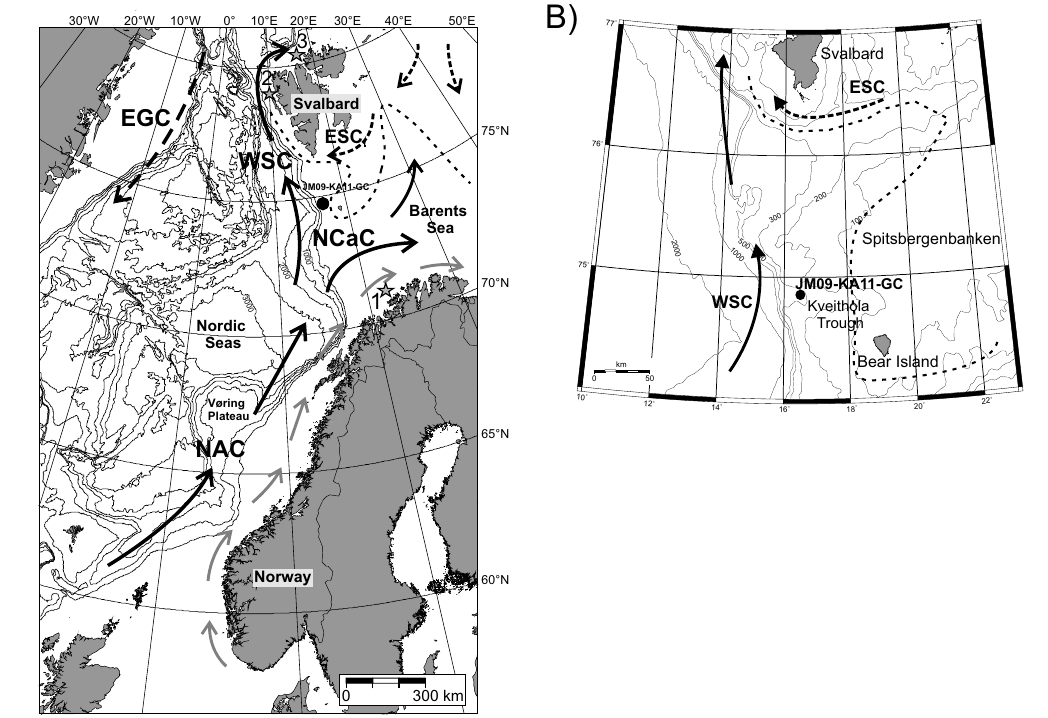
Fig. 1. (A) Location of core JM09-KA11-GC together with main surface current systems in the region. Dashed line indicates the present-day position of the Arctic front (after Loeng, 1991). Black currents indicate Atlantic water, grey currents coastal water, dashed black currents Arctic water. Abbreviations are NAC, North Atlantic Current; NCaC, North Cape Current; WSC, West Spitsbergen Current; ESC, East Spitsbergen Current; EGC, East Greenland Current. Numbers indicate cores used for comparison, 1: core PSh-5159N (Risebrobakken et al., 2010), 2: core NP05-11-21GC (Skirbekk et al., 2010), 3: core NP94-51 (´Slubowska et al., 2005). (B) Detailed map of study area showing location of studied